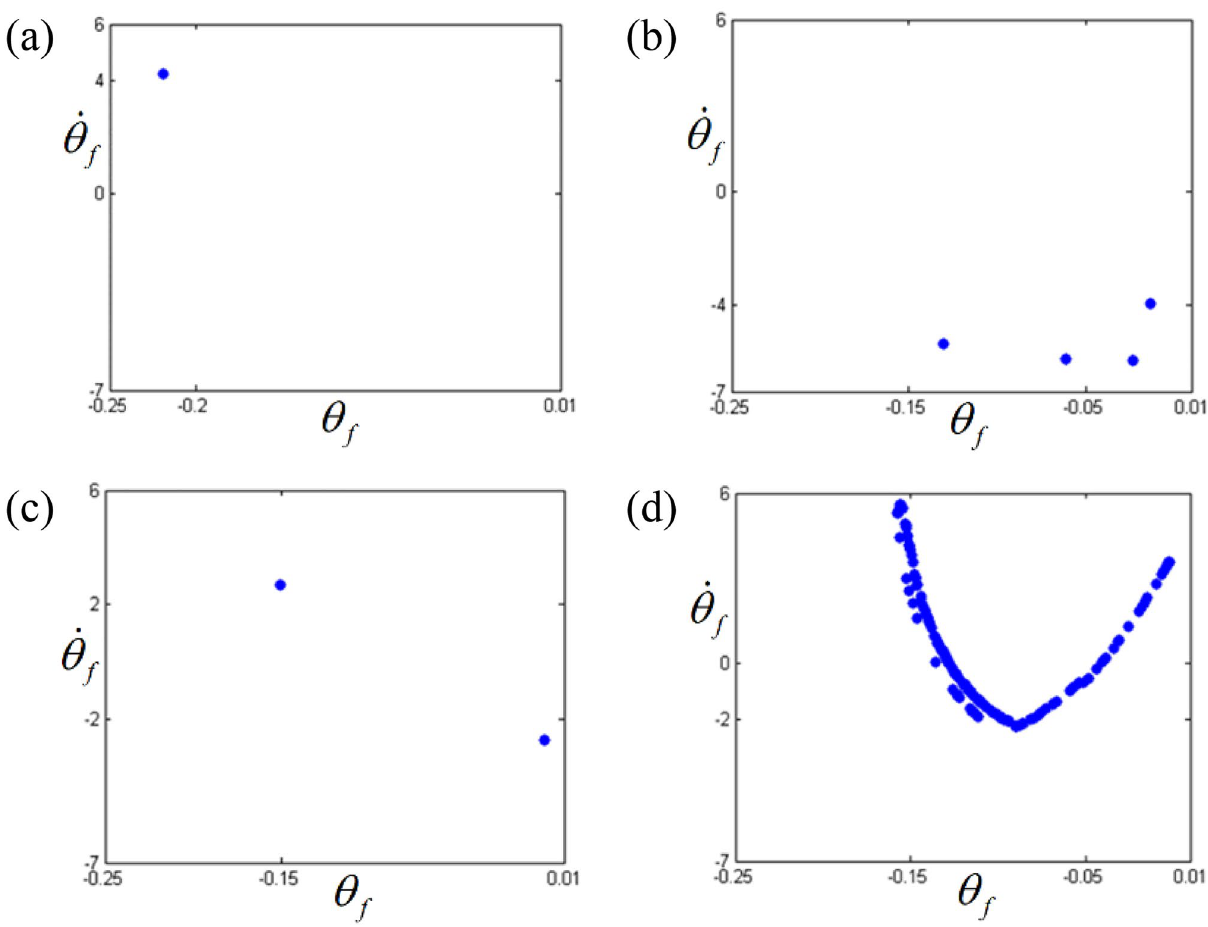
Figure 7. Comparisons of Poincare maps according to different frequency regimes: ( a ) Poincare map at ̟ = 0.26 ; ( b ) Poincare map at ̟ = 0.275 ; ( c ) Poincare map at ̟ = 0.285 ; (d) Poincare map at ̟ = 0.315